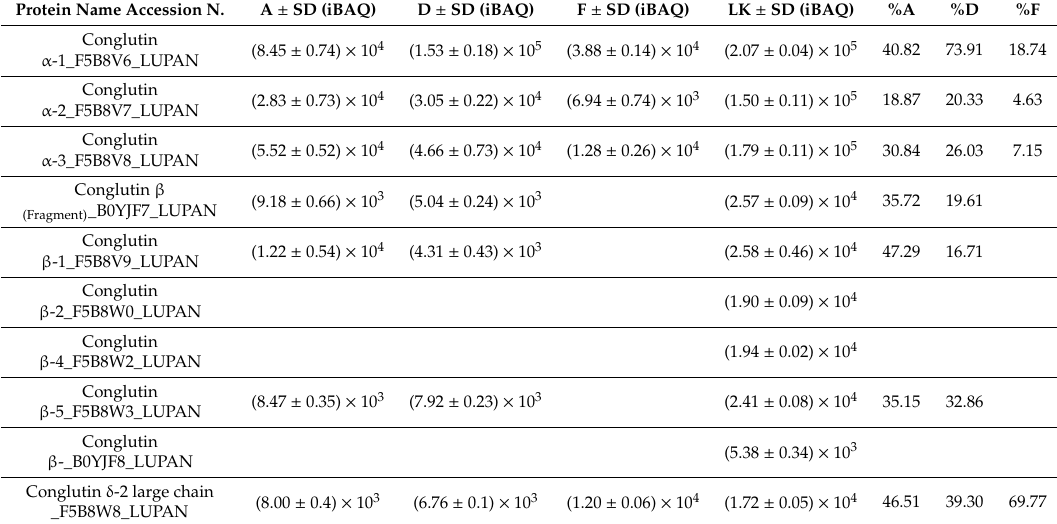
Figure 3. ( A ) iBAQ values of α , β , and δ -conglutin isoforms in samples A, D, F, and LK. ( B ) The log2 fold-changes of the protein levels in A, D, and F versus raw lupin flour (LK). Table 1. iBAQ values and relative percentage of lupin protein identified in lupin-enriched pasta. Protein Name Accession